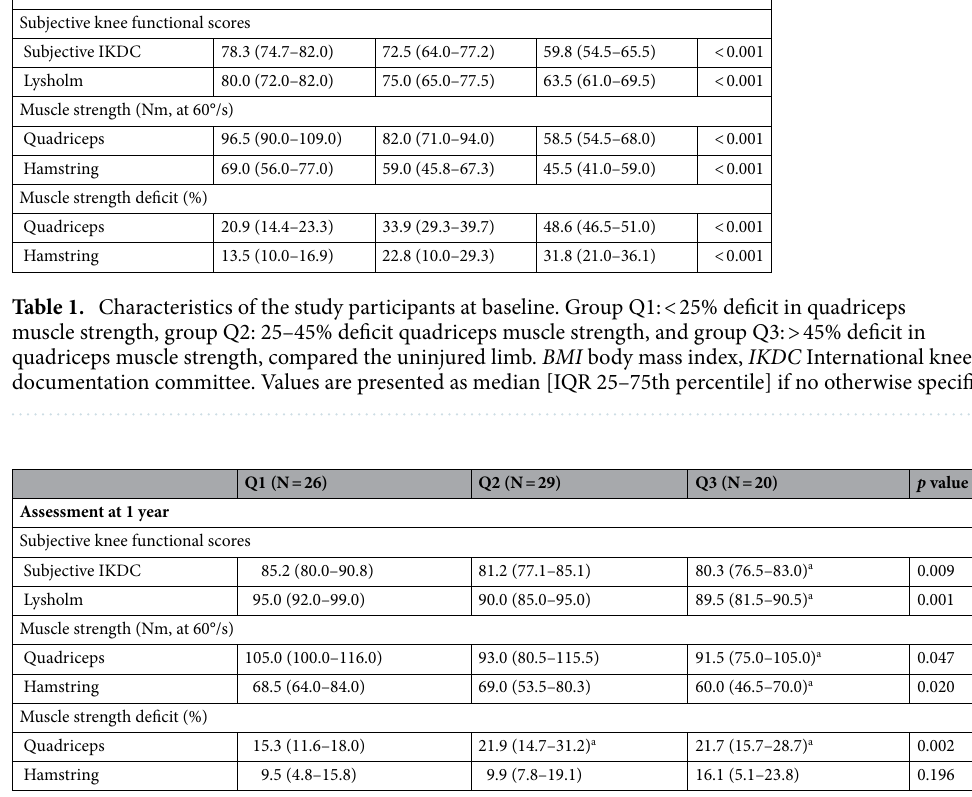
Table 2. Knee functions at 1 year after surgery. Group Q1: < 25% deficit in quadriceps muscle strength, group Q2: 25–45% deficit quadriceps muscle strength, and group Q3: > 45% deficit in quadriceps muscle strength, compared the uninjured limb. IKDC International Knee Documentation Committee. Values are presented as median [IQR 25–75th percentile] if not otherwise specified. a p < 0.05 by post hoc Dunn test, compared with